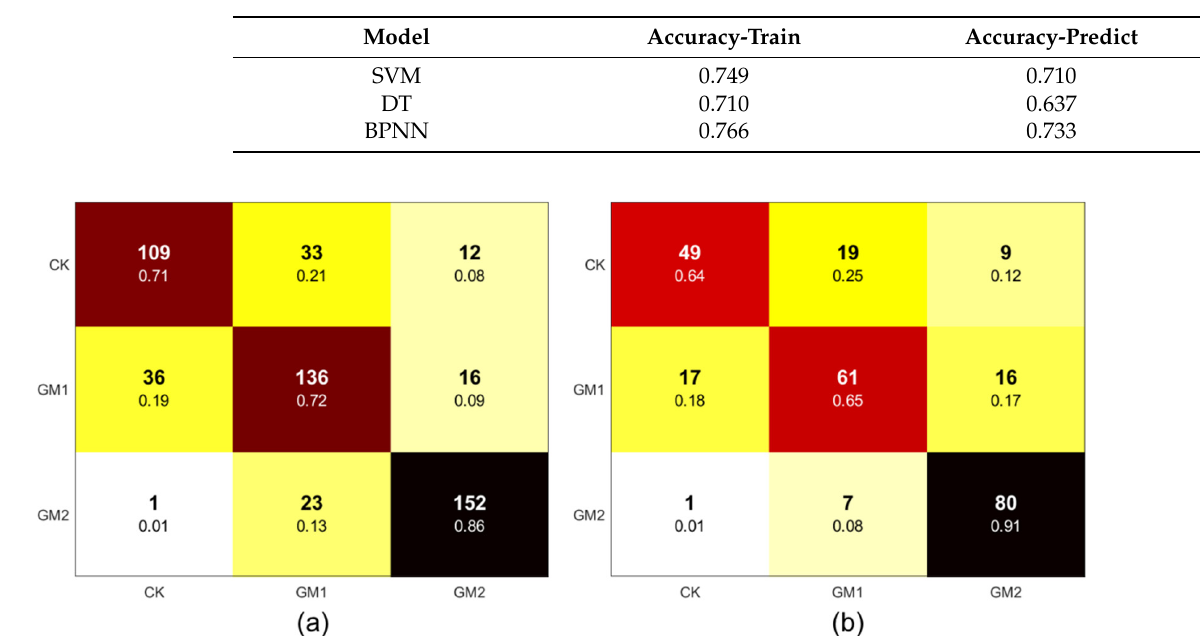
Figure 3. The distribution of all the samples in the 3D space constructed by the first three PCs. Table 1. Performance of SVM, DT, and BPNN models.